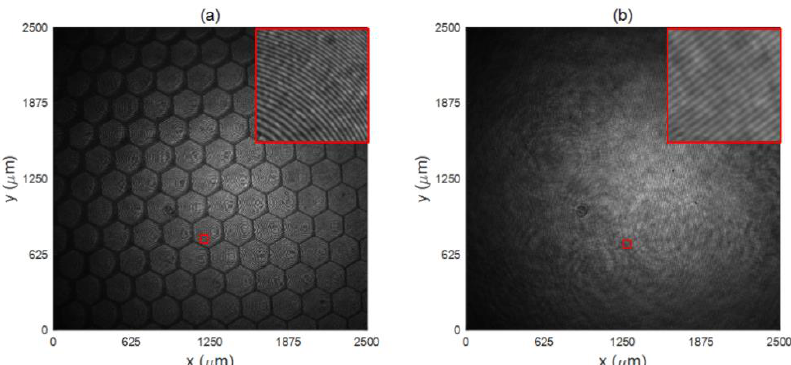
Figure 3. Digital hologram recorded by the CCD camera: ( a ) original hologram and magnified central part obtained by transmission DHM; ( b ) original hologram and magnified central part ob- tained by reflection DHM.